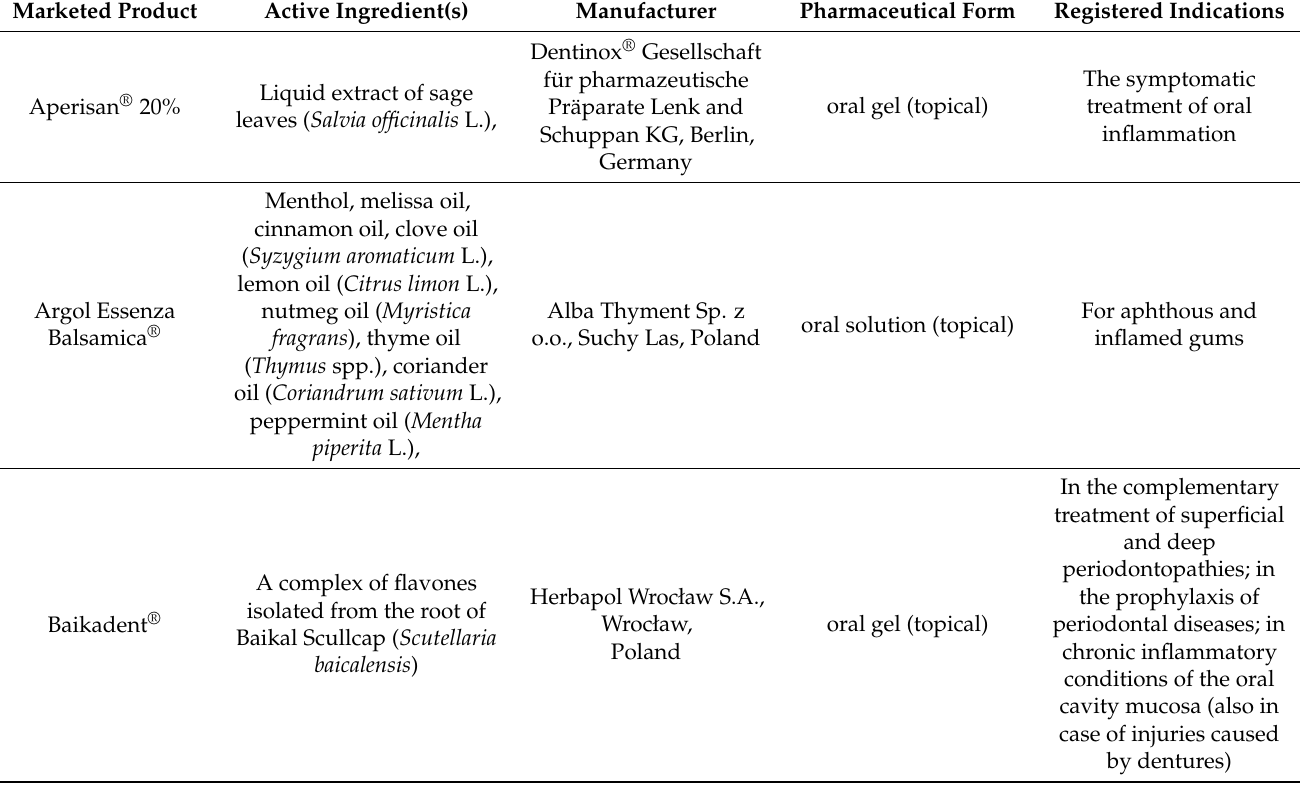
Table 2. Selected preparations marketed as non-prescription medicines in the European Union [171]. Marketed